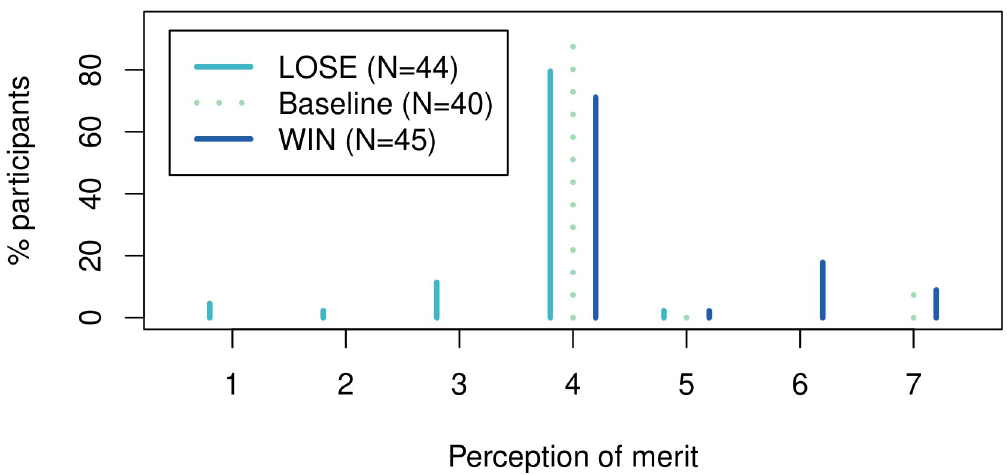
Fig 4. Perception of the relative merits of the participants by treatment condition. 7 implies that the selected player deserves to determine the payoff outcomes more than the other, 1 implies the opposite and 4 implies that the two deserve it equally.